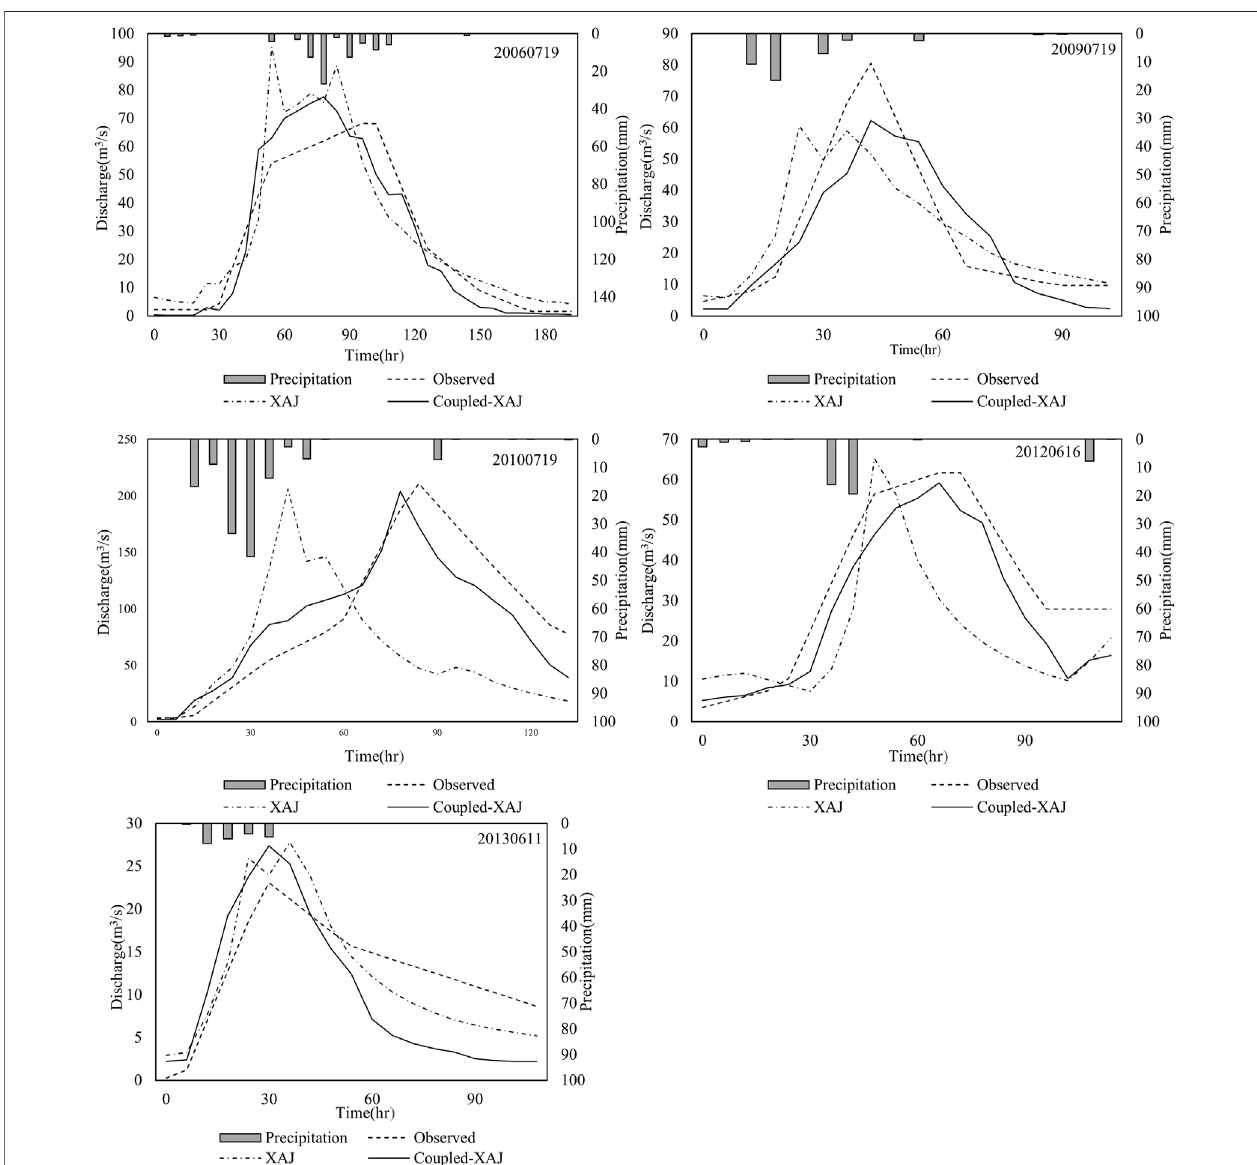
FIGURE 7 | Results of the fl ood